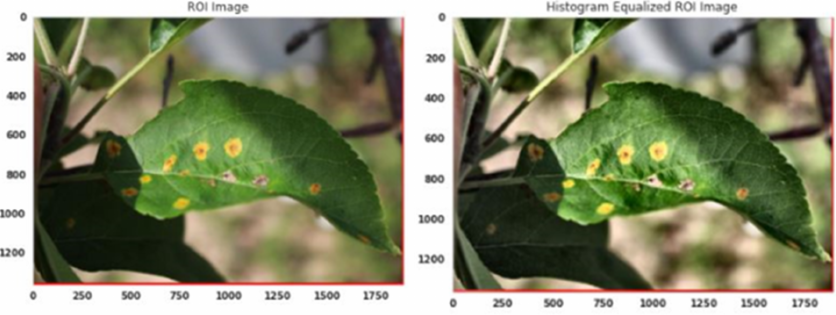
Figure 7. Image Enhancement Using the Local Histogram Equalization on ROI Image.